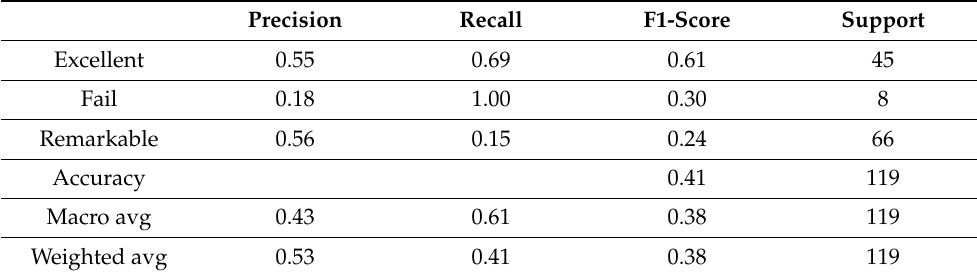
Table 3. Statistical data of the simulation, excluding data from the last month of the semester.